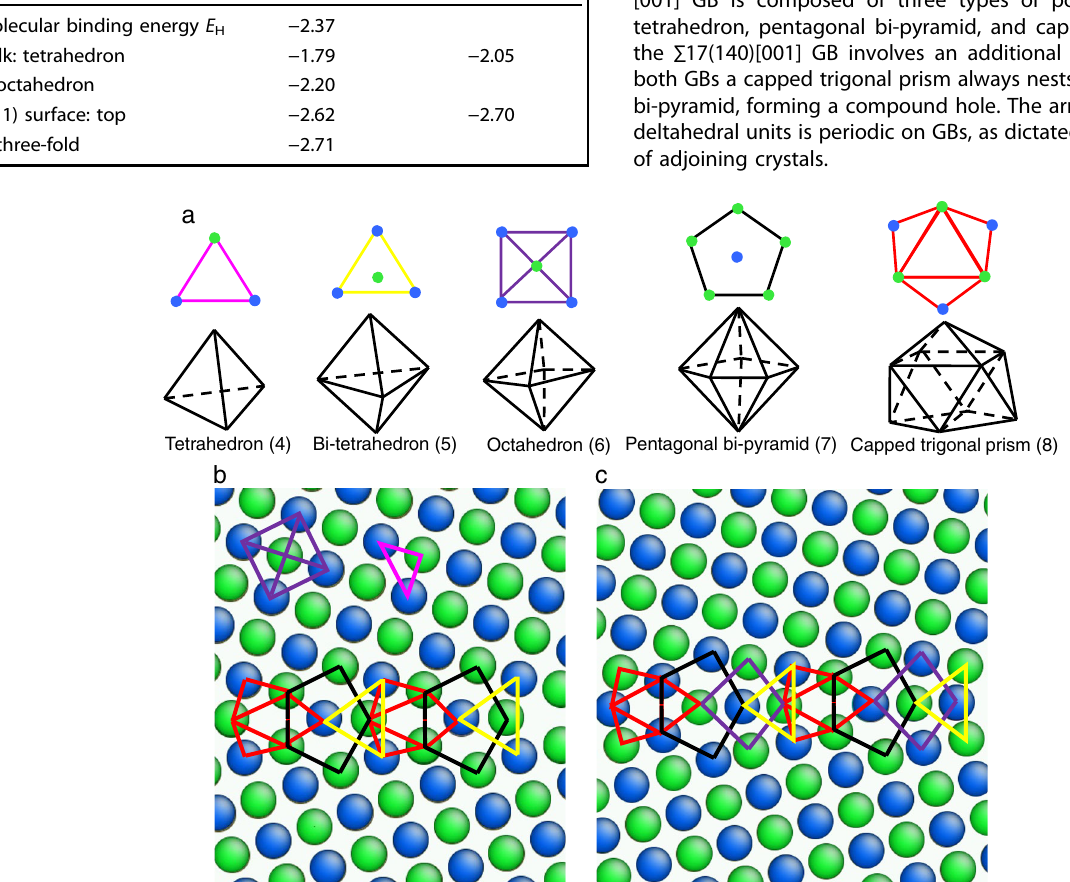
Fig. 1 Symmetric tilt GBs with [001] tilt axis in pure fcc Ni. a Projected and perspective views of deltahedral packing units, with the number of vertices given in the bracket. b A ∑ 5(310)[001] GB is composed of stacks of bi-tetrahedron, pentagonal bi-pyramid, capped trigonal prism; the latter two units form a compound hole. The types of projected deltahedral units in the bulk lattice and at the GB can be recognized from the edge color as de fi ned in a . c A ∑ 17(140)[001] GB is composed of stacks of the above three deltahedral units plus an octahedral unit. Green and blue atoms belong to adjacent (001)